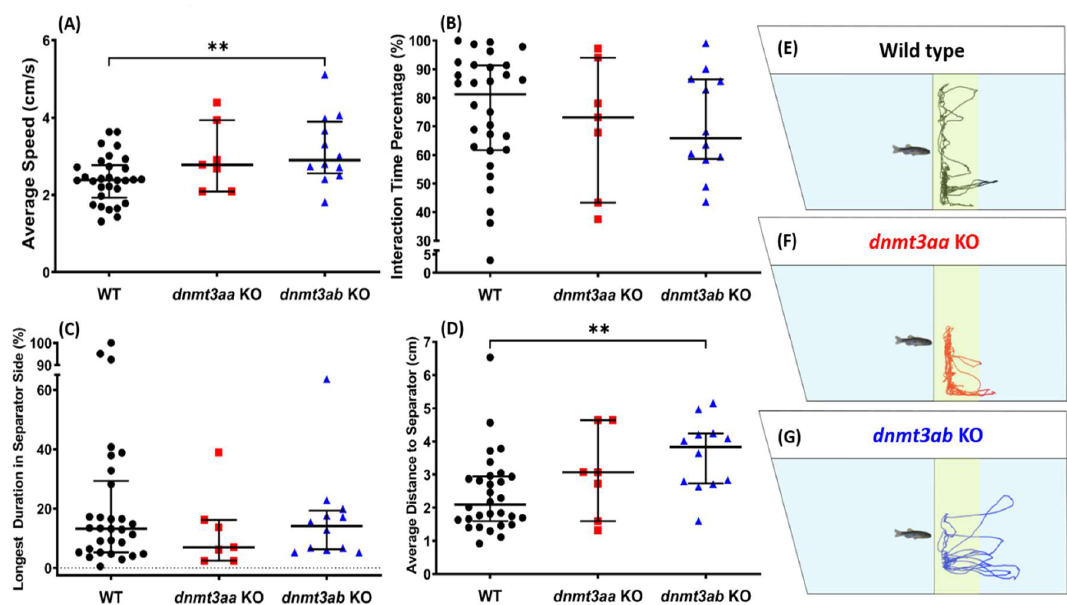
Figure 6. Comparison of conspecific behavior endpoints among the wild-type, dnmt3aa , and dnmt3ab mutant fish. ( A ) Average speed, ( B ) interaction time percentage, ( C ) longest duration in separator side, and ( D ) average distance to separator were analyzed. The data are expressed as the median with interquartile range and analyzed by Mann–Whitney test ( n = 30 for wild type; n = 7 for dnmt3aa KO fish; n = 12 for dnmt3ab KO fish; ** p < 0.01). ( E – G ) The locomotion curve trajectories of a single fish of the wild type, dnmt3aa KO, and the dnmt3ab KO fish, respectively, during the social interaction test. The conspecific interaction zones were highlighted with yellow color.